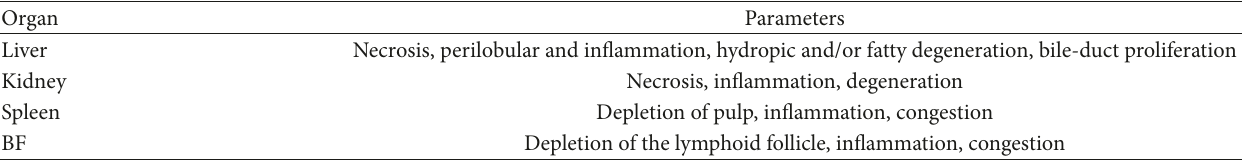
Table 3: Semiquantitative scoring systems for poultry